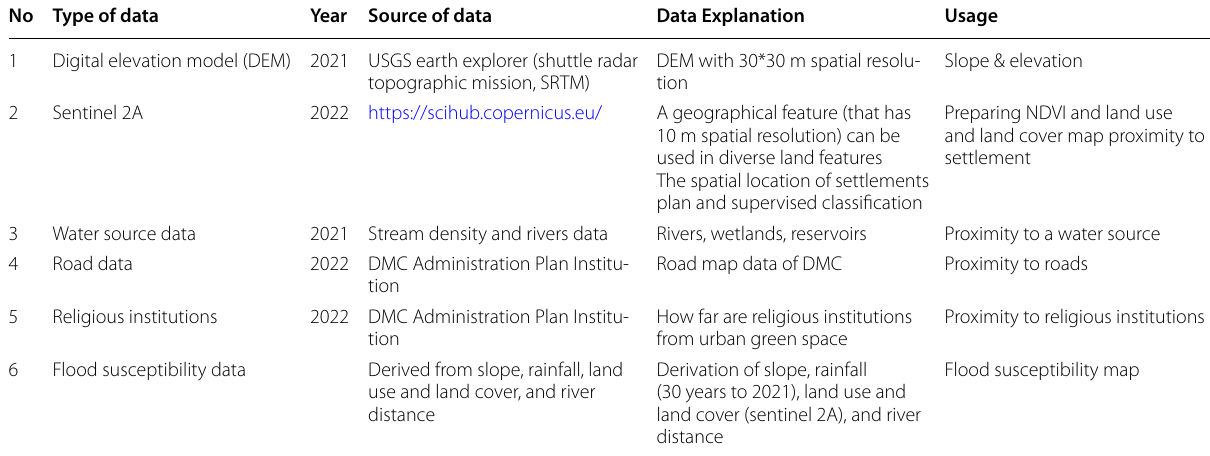
Table 1 Sources of data and data type